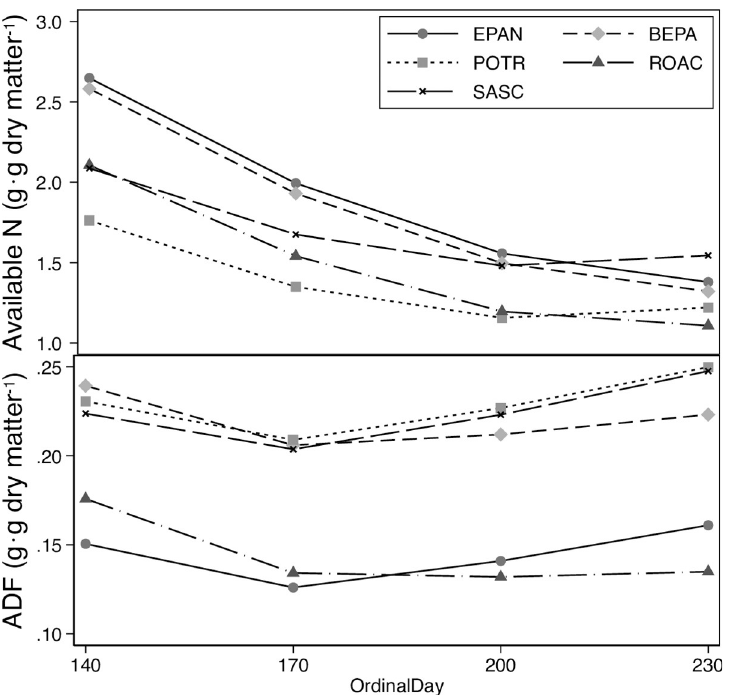
Fig 2. Forage quality. Phenology of available N (g � 100 g -1 ; top panel) and fiber content (ADF g � g -1 dry matter; bottom panel) of forages available to moose through the summer (May–August; ordinal day 140–240) at the Kenai Moose Research Center, Kenai Peninsula, Alaska, USA, in 2014–2016. Symbols are estimated margins for each species. Lines are predicted relationships from mixed model regressions of concentration against time. Key: Betula papyrifera (BEPA)–dashed line and gray diamond; Populus tremuloides (POTR)–dotted line and gray square; Rosa aciculari (ROAC)–dashed line with dots and black triangle; Salix scouleriana (SASC)–short dashed line and black x’s; Epilobium angustifolium (EPAN)–solid line and black circle. The period of early lactation is from ordinal day 140 to 170.